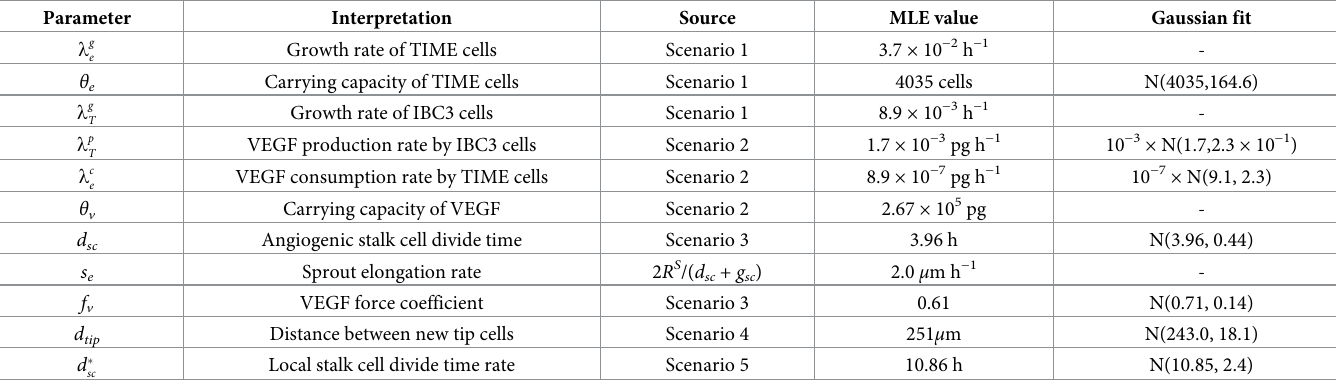
Table 6. Calibrated model